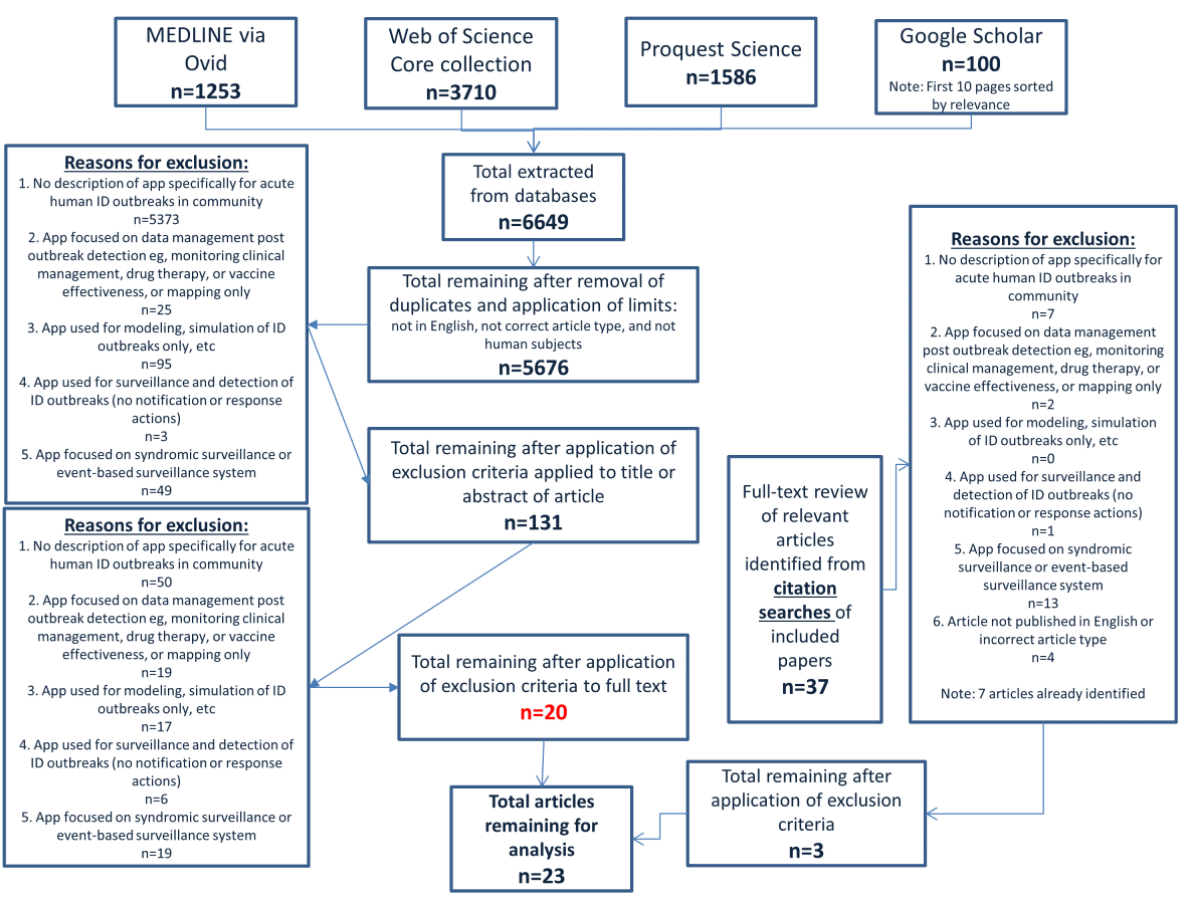
Figure 1. Systematic search strategy results. ID: infectious